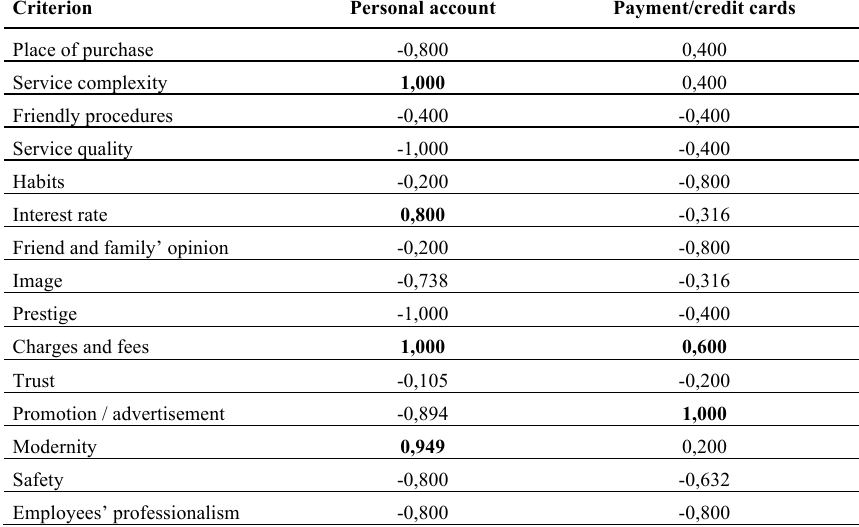
Table 5. The relationship between financial literacy and criteria of financial decisions among young educated financial